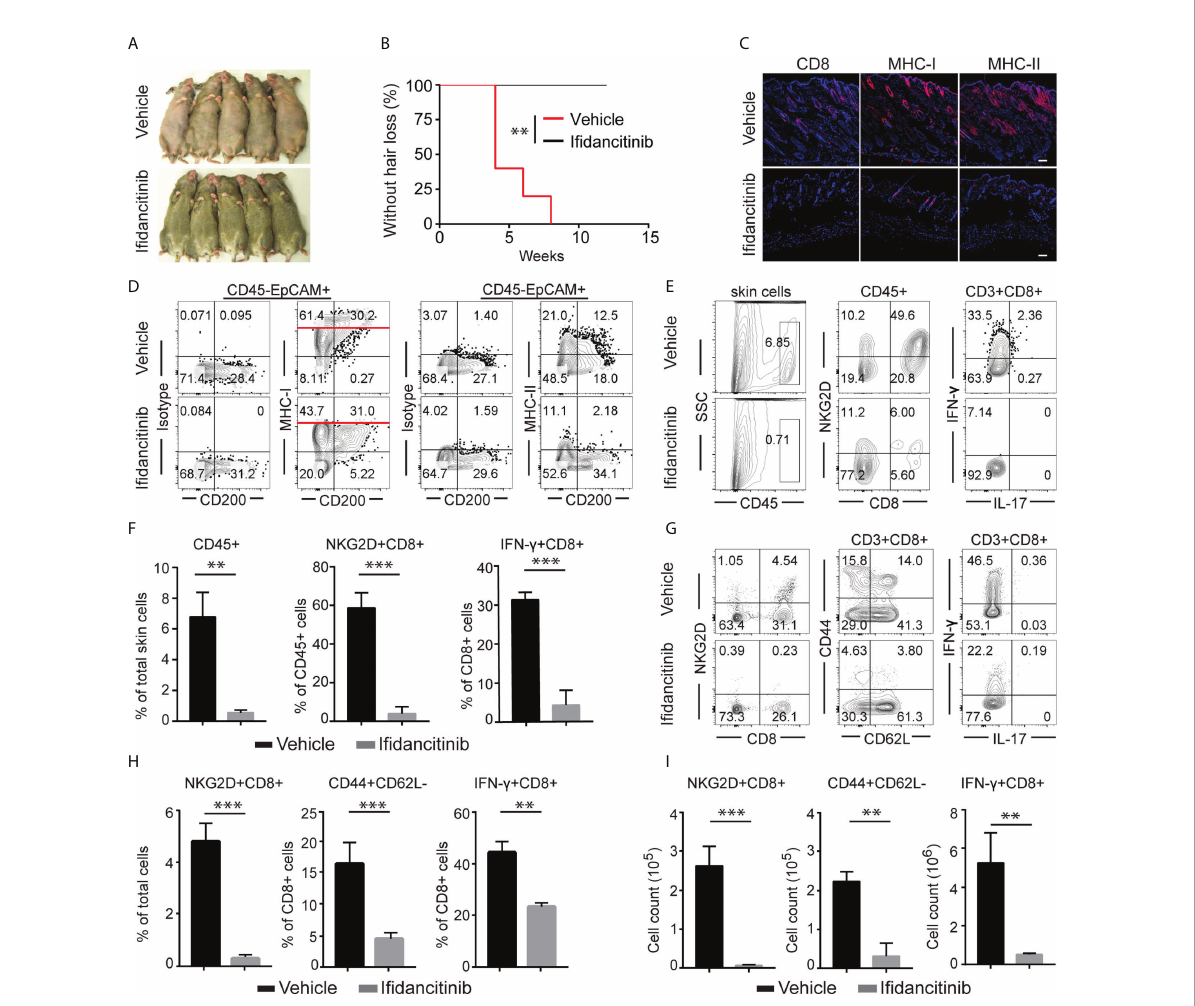
FIGURE 2 I fi dancitinib prevented the onset of alopecia in AA skin grafted C3H/HeJ mice. Mice were given either I fi dancitinib (n=10) or vehicle control (n=10) in chow diets beginning the day of grafting. AA skin grafted C3H/HeJ mice were given either I fi dancitinib or vehicle control in chow diets for 12 wks. (A) The onset of alopecia was inhibited by I fi dancitinib. **P < 0.01, log-rank test. (B) Time course of onset of AA in control mice and I fi dancitinib treated mice was shown as weeks after grafting. (C) Representative immuno fl uorescence images of skin sections stained with anti- CD8, anti-MHC-I, or anti-MHC-II mAbs. Dashed scale bars represent 100 µm. (D) Representative FACS plots of skin cell suspension showed the expression of MHC class I and II on HF (gated on CD45-EpCAM+CD200+). (E) and (F) Representative FACS plots of cell suspension of mouse skin and the frequencies of in fi ltrating CD45 + leukocytes and IFN- g -producing CD8 + NKG2D + T cell in skin of I fi dancitinib treated mice and control mice. **P < 0.01, ***P < 0.001 (Unpaired Student t test). (G) to (I) Representative FACS plots of cell suspension of mouse SDLNs (G) ,the frequencies (H) and total cell numbers (I) of indicated T cell subsets. **P < 0.01, ***P < 0.001 (Unpaired Student t